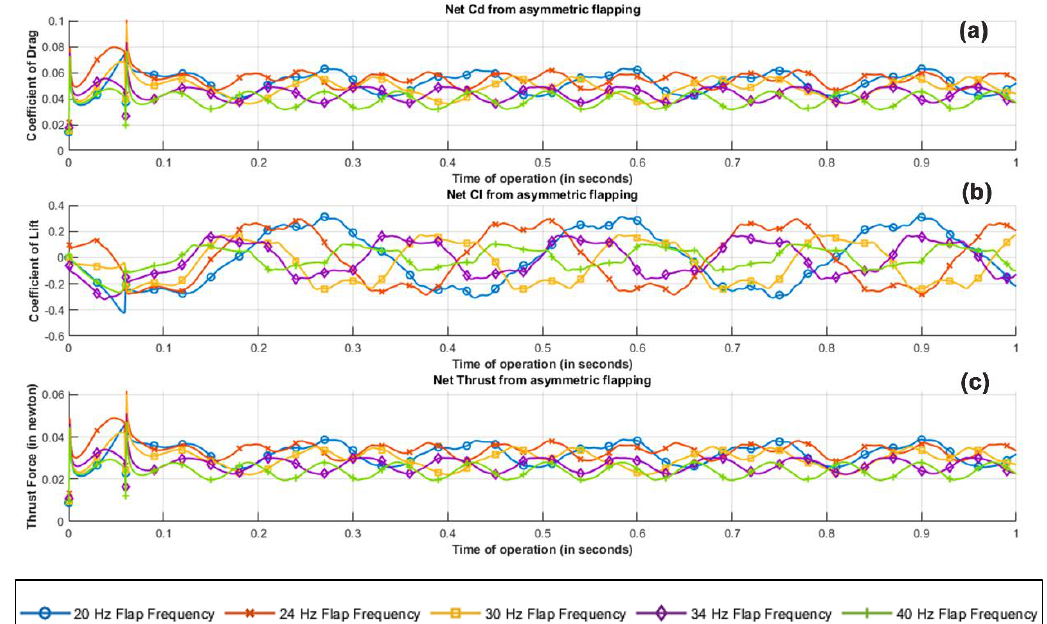
Figure 20. Net flow field metrics of asymmetric flapping plate configuration; ( a ) coefficient of drag, ( b ) coefficient of lift, ( c ) thrust force along the positive x axis.